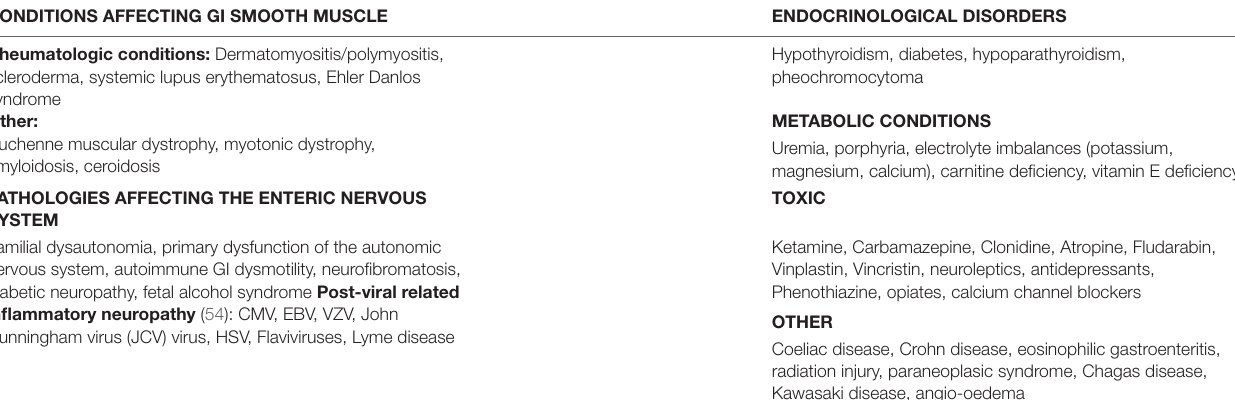
TABLE 2 | Secondary causes of Pediatric Intestinal